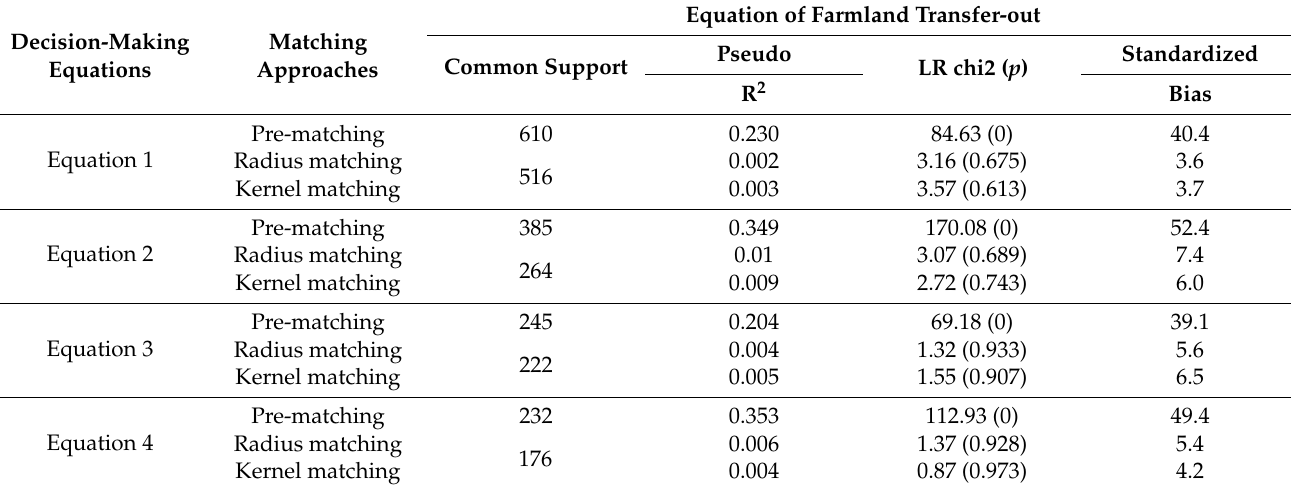
Table 4. Results of common support and data balancing estimation for farmland transfer-out equations.